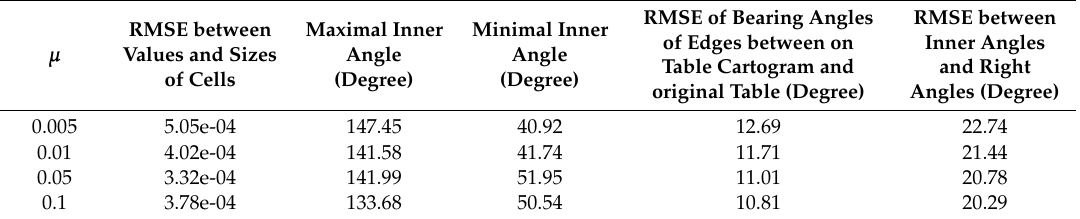
Table 1. Data representation precision and deformation with di ff erent values of µ .